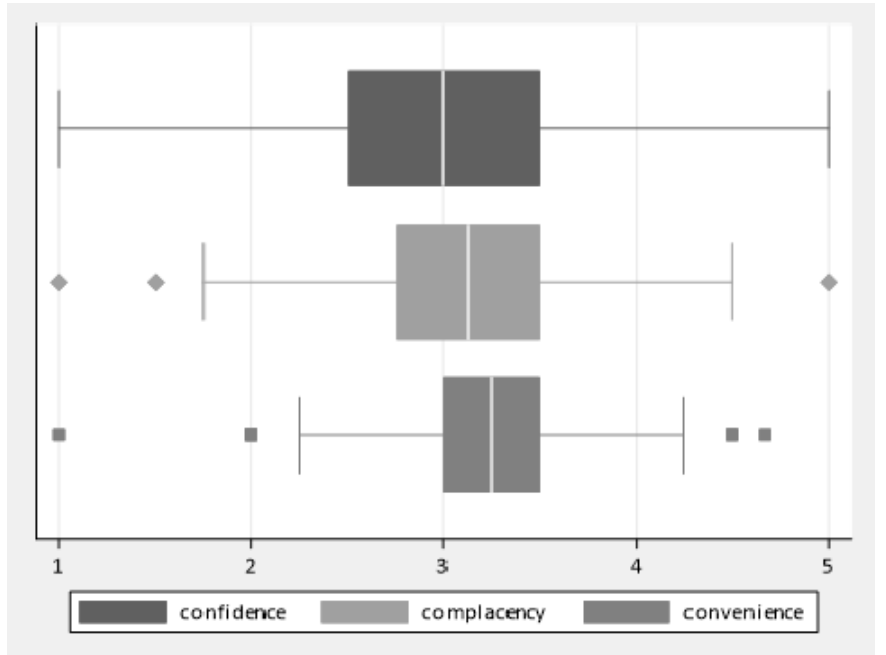
Figure 3. Box plots of the score distribution of the three factors.